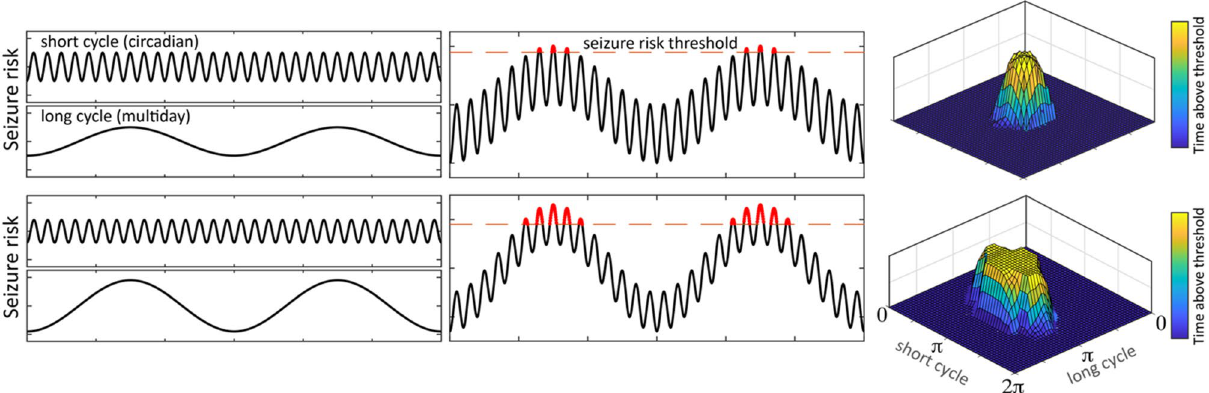
Figure 6. Multiscale cycles of seizure risk and seizure phase locking model. Multiscale seizure risk cycle model of the impact of cycle amplitude on seizure phase locking and seizure clustering. The upper panels show short and long cycles of seizure risk independently (left panels), and in combination (center panels). The right panel phase–phase plots mark the phase angle above a theoretical high seizure risk threshold for both the short and long cycles. As the amplitude of the long seizure risk cycle increases (lower panel), a greater proportion of the short cycle falls above the threshold line, which would result in reduced seizure phase locking to the short cycle. During the high risk phase of the long cycle there is an increased risk of seizure clustering as a greater proportion of each short cycle falls above the high seizure risk threshold. In this model, the amplitude of seizure risk cycles is positively correlated with the amplitude of IES rate cycles, however, there are phase shifts between these cycles (for multiday IES rate cycles peak seizure risk occurs during the rising phase of cycles; for circadian IES rate cycles the phase of peak seizure risk is subject specific). IES interictal epileptiform